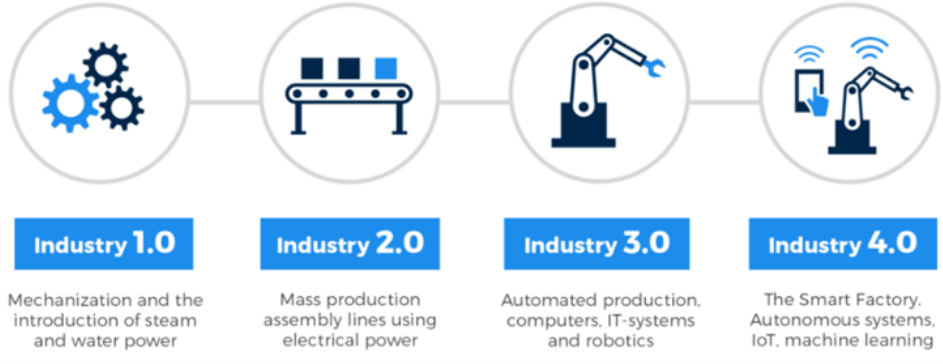
Figure 17. Industry Developments, 1st to 4th industrial revolution